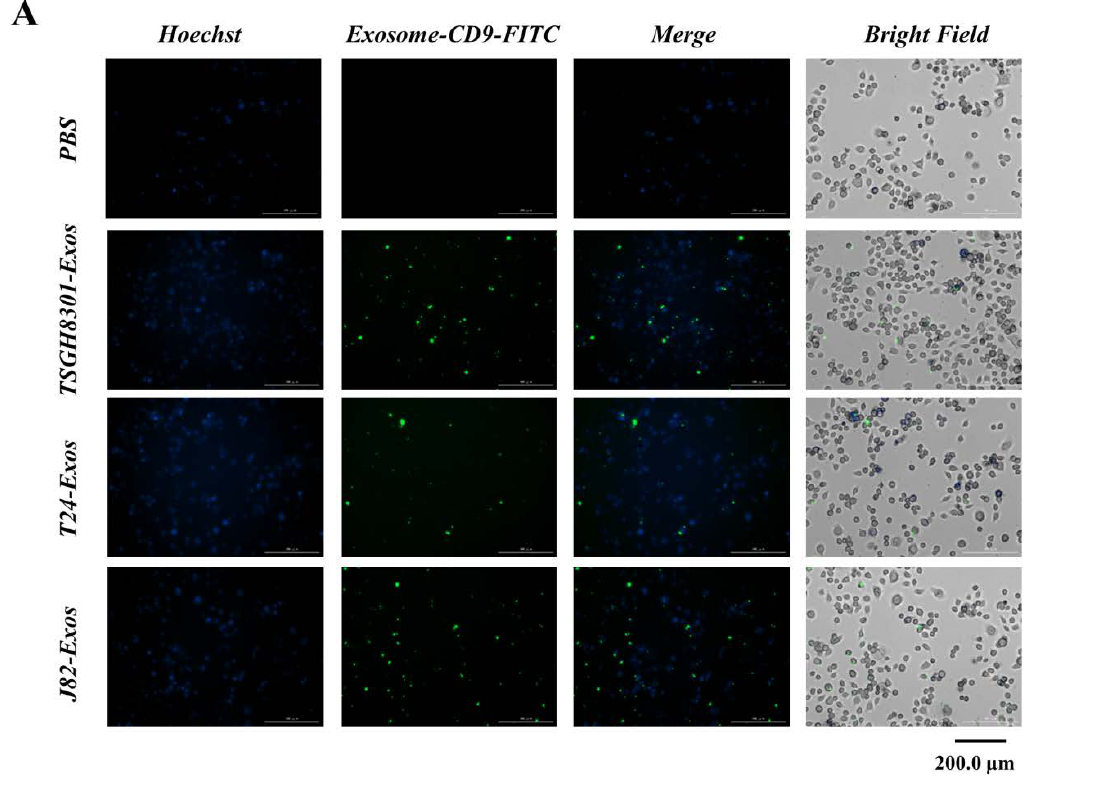
Figure 2. Exosomes serve as a mediator in intercellular communication. Exosomes derived from bladder cancer cells were labeled with FITC-conjugated anti-CD9 antibody (green) and counterstained with Hoechst 33342 (blue) for 24 h, and exosomes uptake was observed under a BioTek LIONheart FX microscope ( A ) for different spectra, and ( B ) merged figures were aligned upon different time points. 3.4. T24-Exos and J82-Exos Promote the Malignant Behavior of Recipient TSGH-8301 Cells